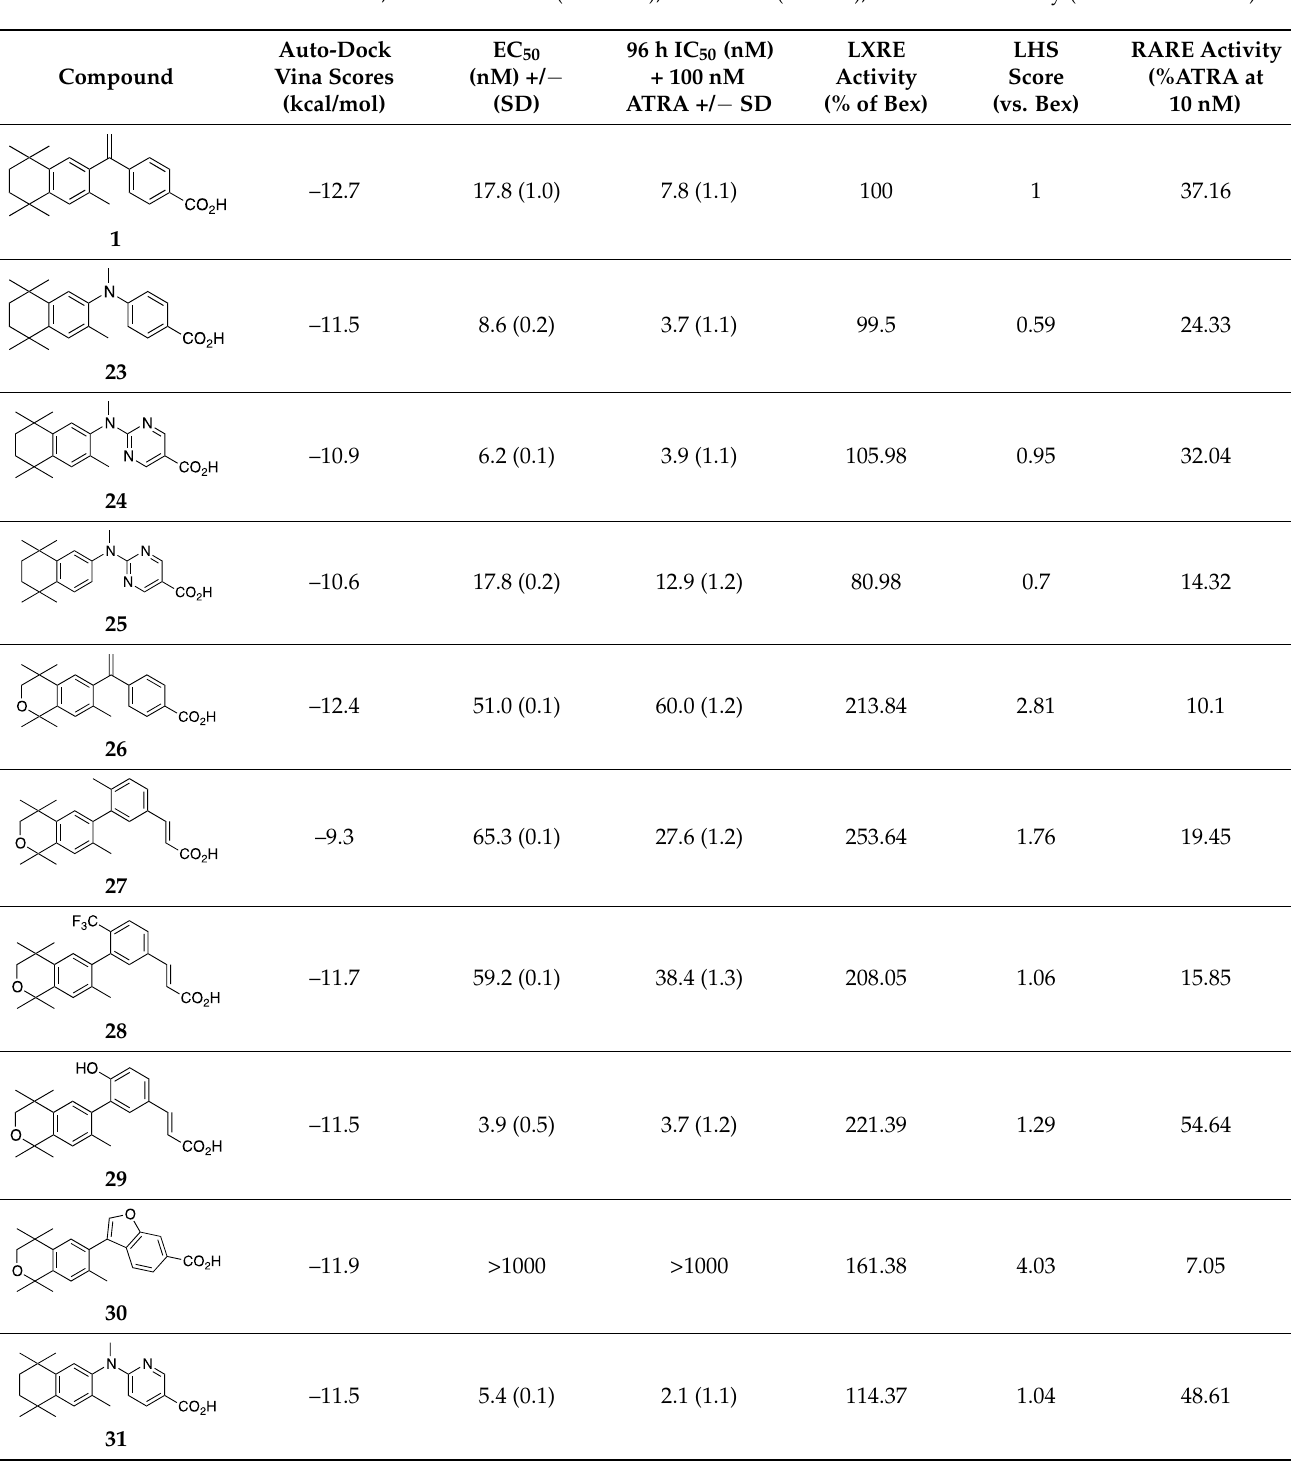
Table 1. Tabe of Auto-Dock Vina Binding Energies, EC 50 (nM) values, 96h IC 50 (nM) + 100 nM ATRA values, LXRE Activities (% of Bex), LHS Score (vs. Bex), and RARE Activity (%ATRA at 10 nM).